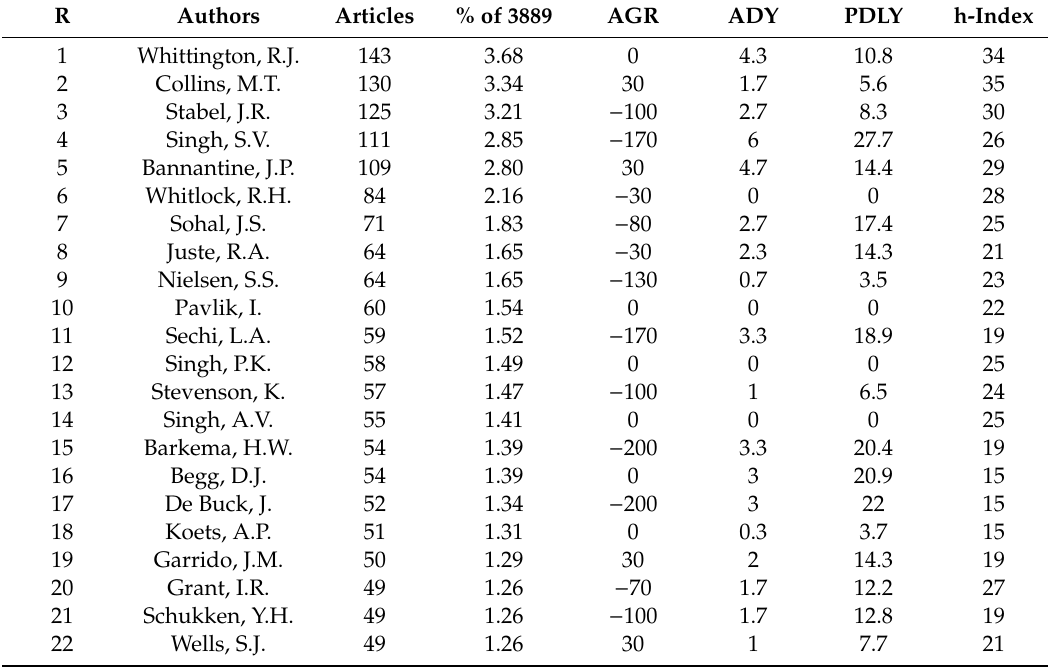
Table 2. The top 20 productive / active authors in MAP research from 1911–2019.